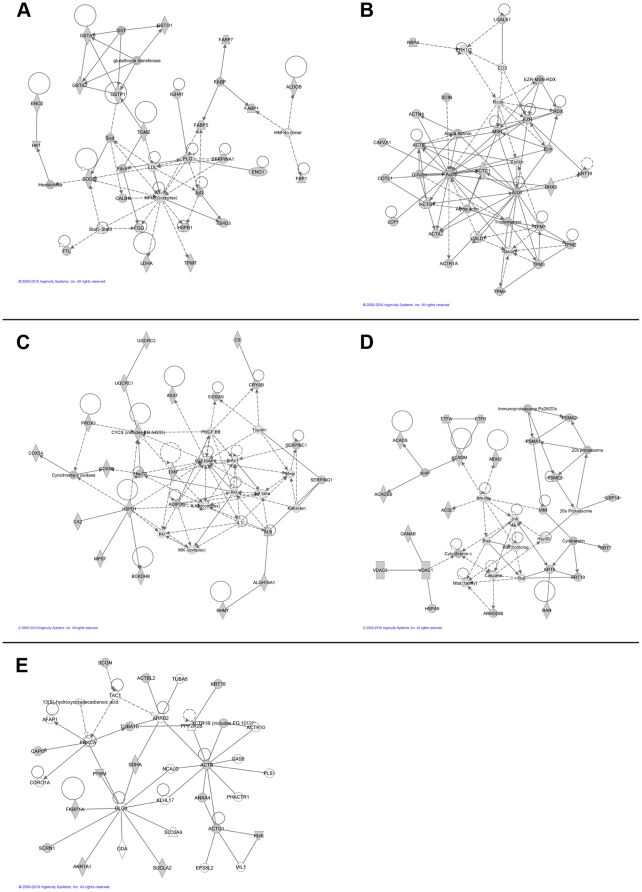
Protein networks of differentially expressed proteins kidney cancer.Ingenuity Pathway Analysis was used to generate a network of direct connections between all identified proteins with altered expression. Grey filled boxes are the differentially expressed proteins. Most significant sub networks were shown in the figure. A Lipid Metabolism, Molecular Transport, Small Molecule Biochemistry. 24 proteins out of 36 proteins in the network were confirmed with this analysis B Cellular Assembly and Organization, Skeletal and Muscular System Development and Function, Tissue Morphology. 22 proteins out of 33 proteins in the network were confirmed with this analysis. C Cellular Movement, Hematopoiesis, Immune Cell Trafficking. 21 proteins out of 35 proteins in the network were confirmed with this analysis. D Genetic Disorder, Metabolic Disease, Embryonic Development. 21 proteins out of 34 proteins in the network were confirmed with this analysis. E Lipid Metabolism, Small Molecule Biochemistry, Cancer. 16 proteins out of 33 proteins in the network were confirmed with this analysis.